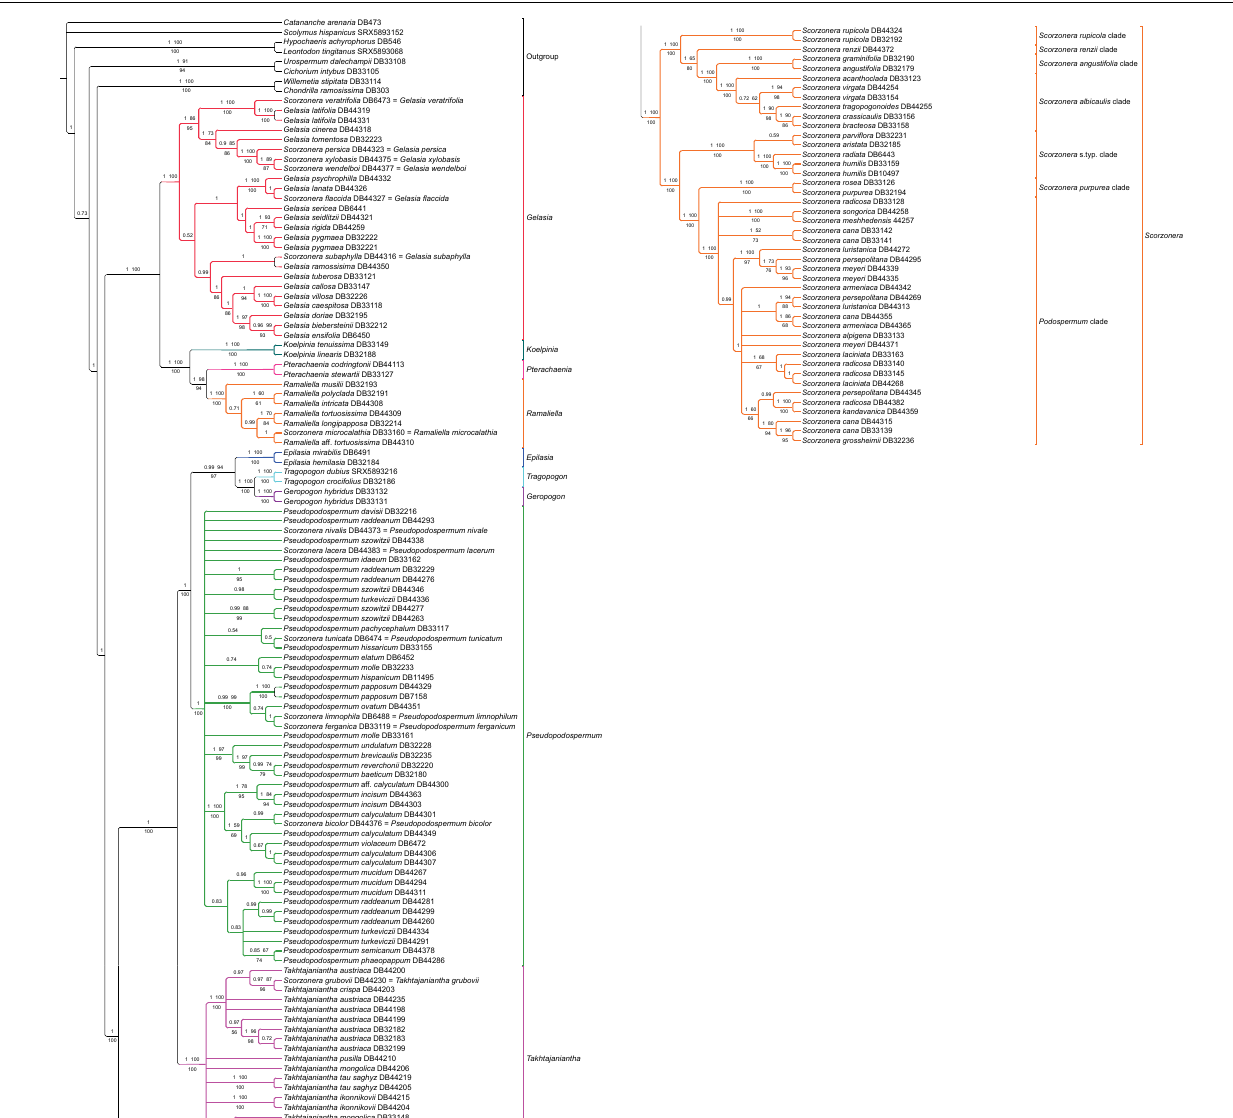
Scorzonera s.typ. clade, S. albicaulis clade, and S. angustifolia clade, but different positions of the S. renzii and S. rupicola clades across